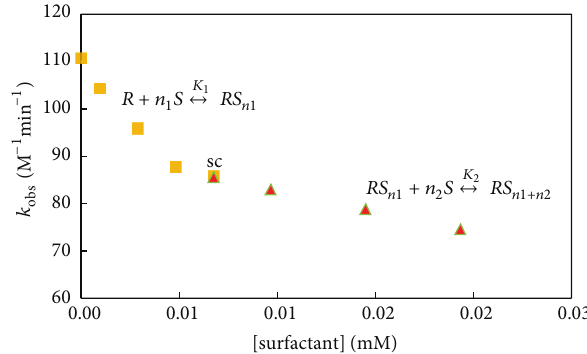
Figure 3: Typical equilibrium relations between reactant and surfactant molecules in a two-region